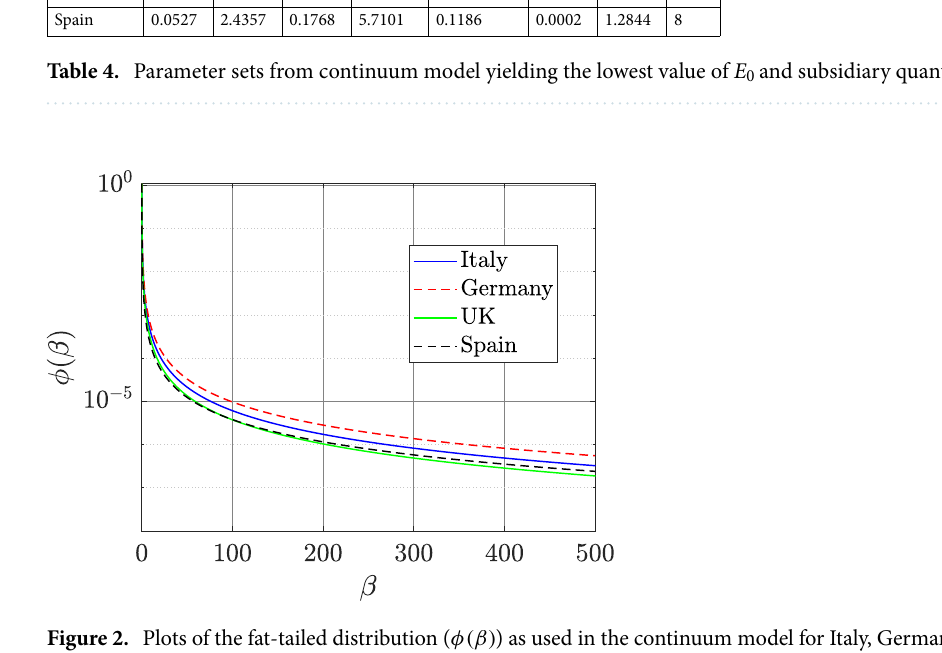
Figure 2. Plots of the fat-tailed distribution ( φ(β) ) as used in the continuum model for Italy, Germany, the UK, and